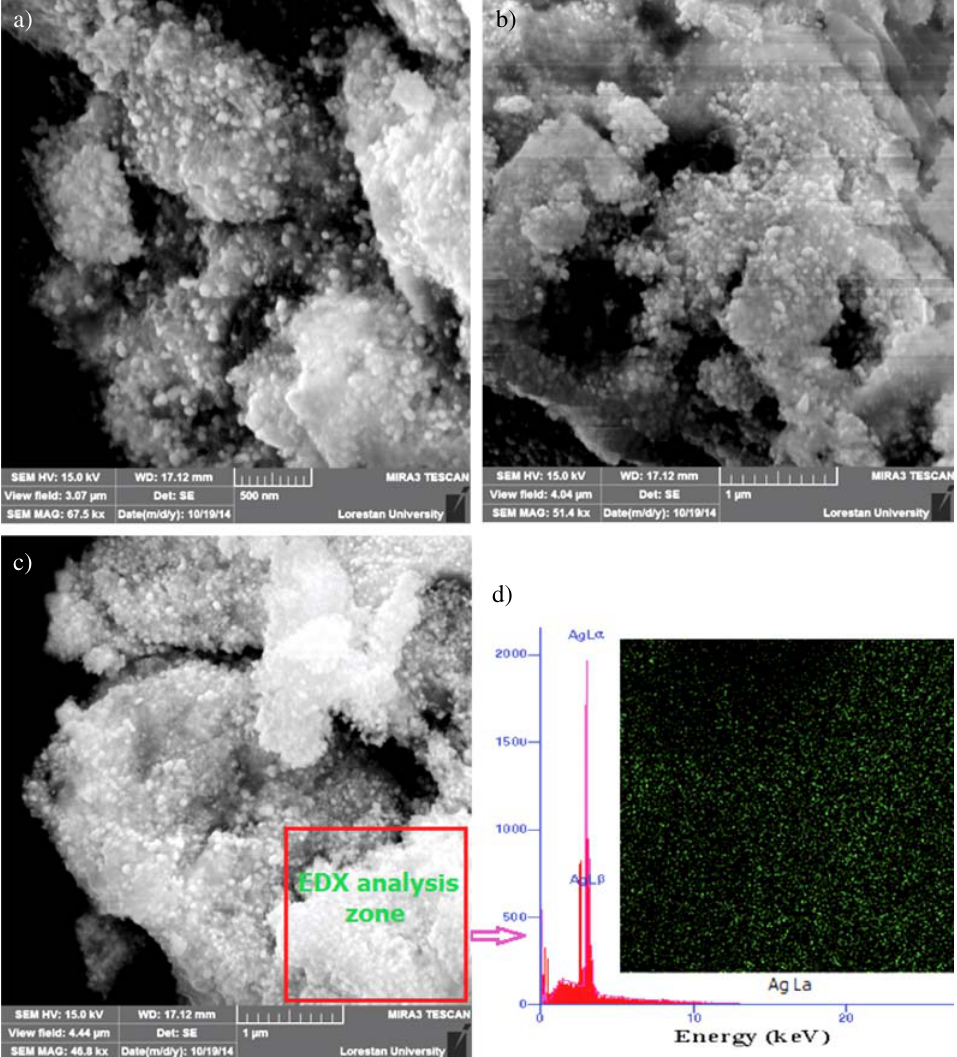
Figure 5. (a–c ) SEM images of the as-prepared Ag NPs, (d) EDX elemental spectrum of the Ag NPs. The inset of Figure 5(d) shows EDX elemen- tal mapping for Ag NPs.